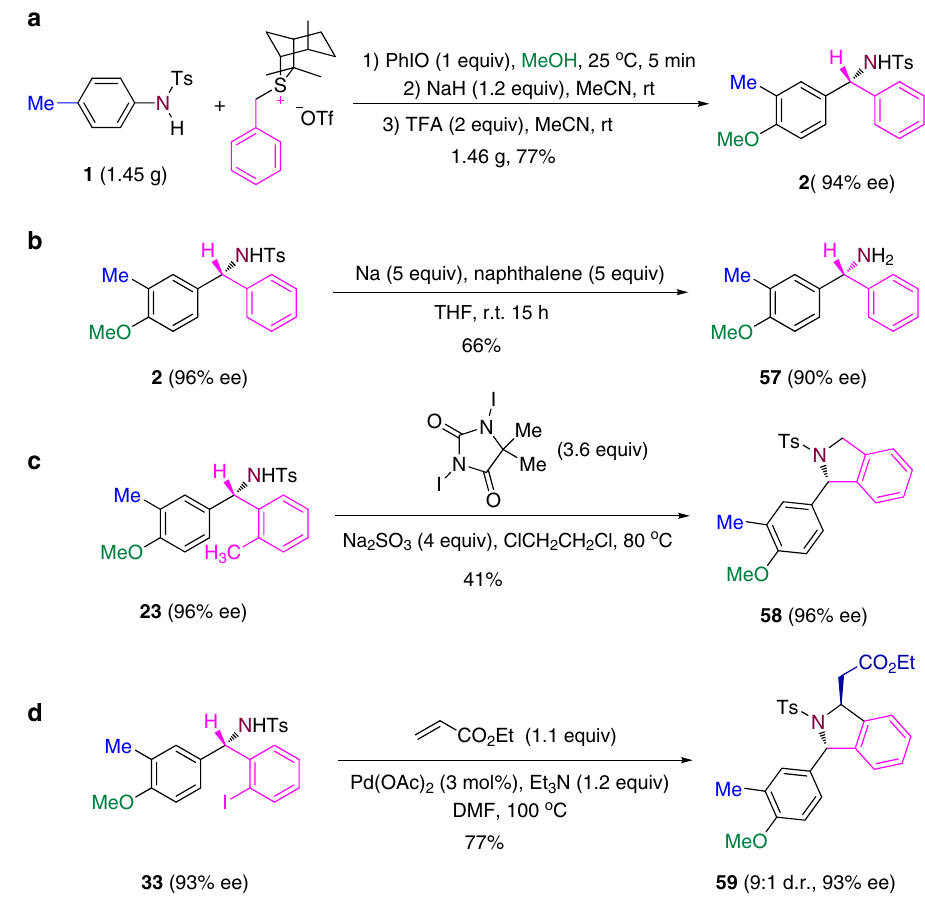
Fig. 8 Reaction in a gram scale and transformations of the one-carbon insertion products. a Reaction in a gram scale. b Removal of the N-tosyl protecting group of compound 2 . c Radical amination reaction of compound 23 to form 1-substituted isoindoline. d Pd-catalyzed cascade coupling/ cyclization reaction of compound 33 to form 1,3-disubstituted